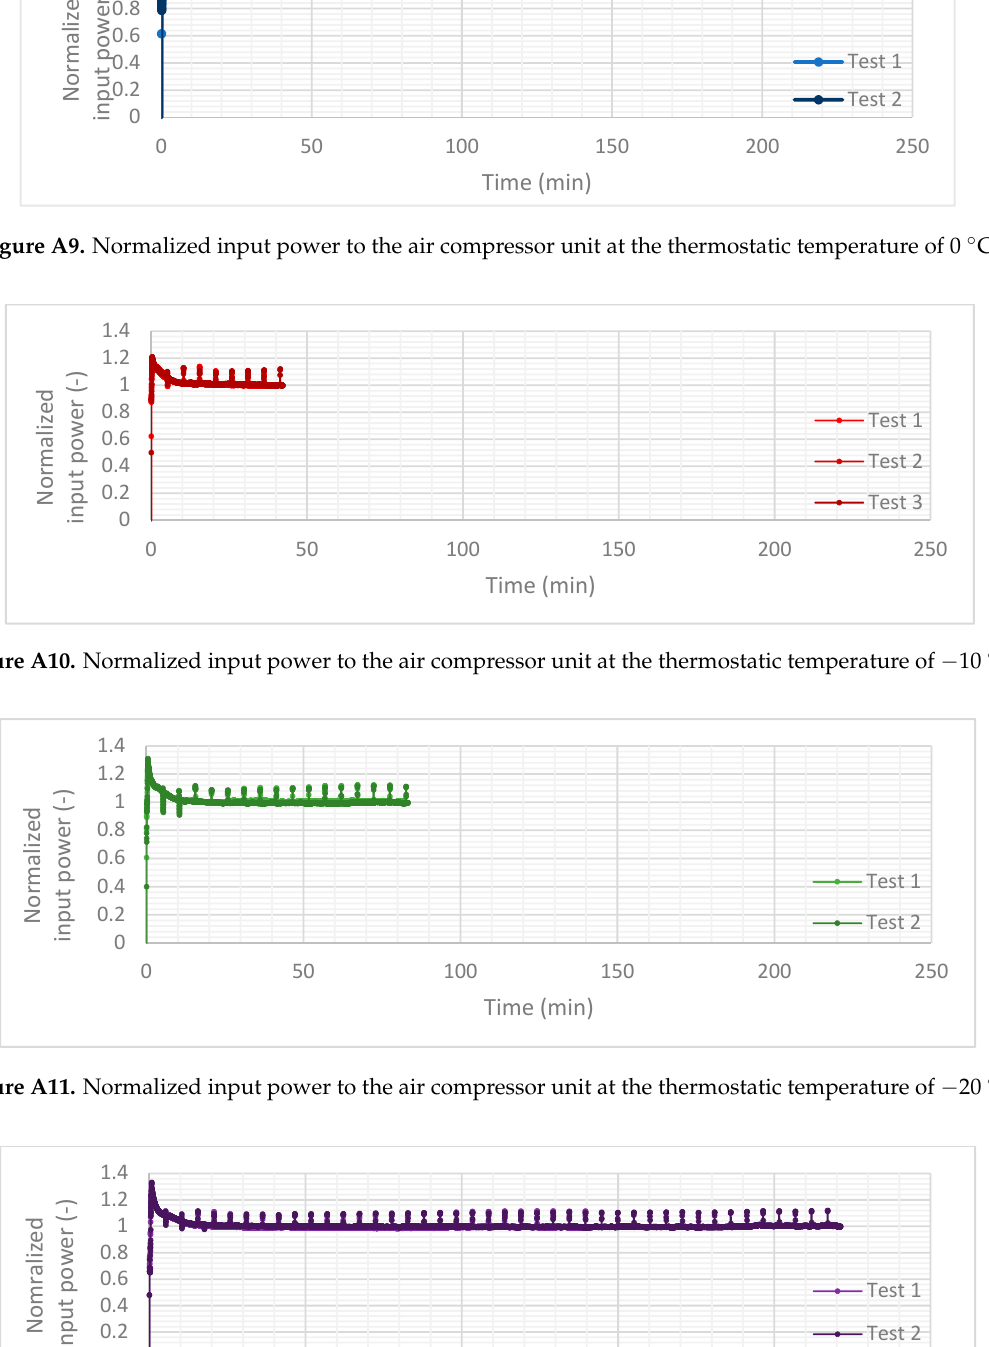
the two repetitions.